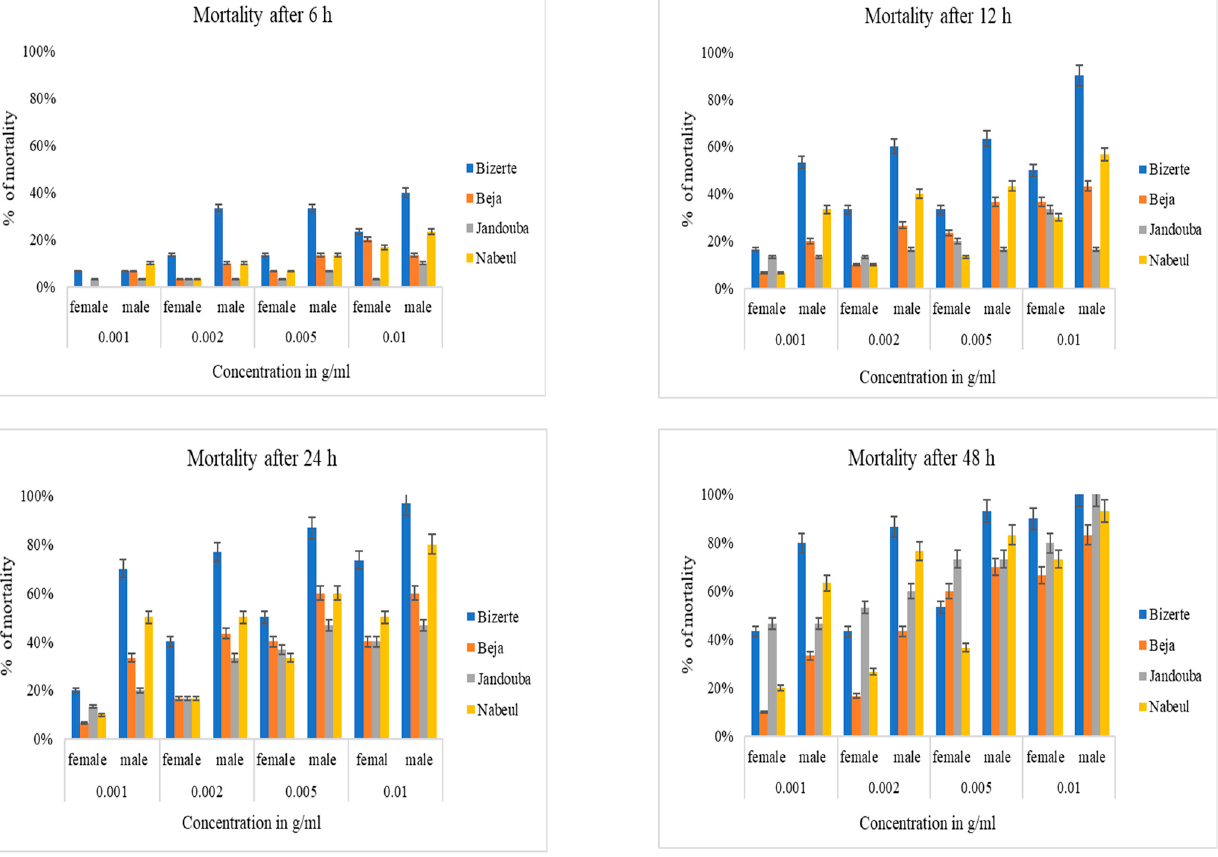
Figure 5. Mortality (%) after 6, 12, 24 and 48 h of T. confusum subjected to the different concentrations of the aqueous extract of the leaf powders of the female and male plants of M. annua from four provenances. Table 2. Larvicidal activity of M. annua leaf extract against T . confusum.